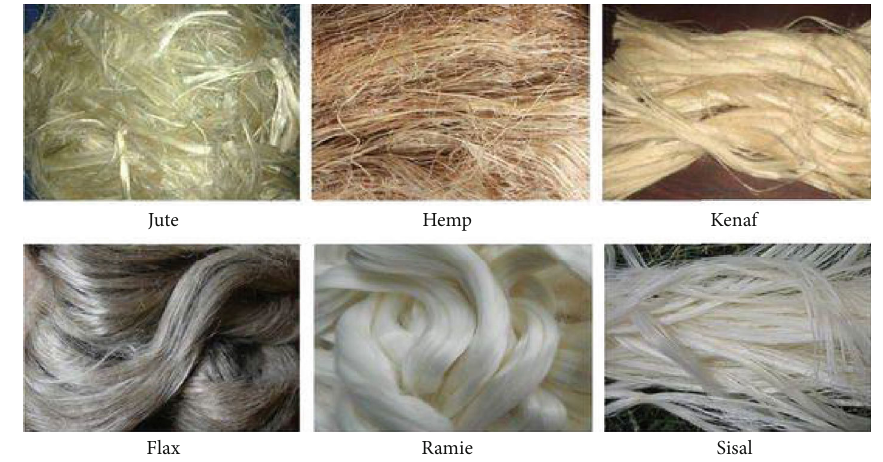
Figure 1: Di ff erent type of natural fi bers that can be used for composite reinforcement